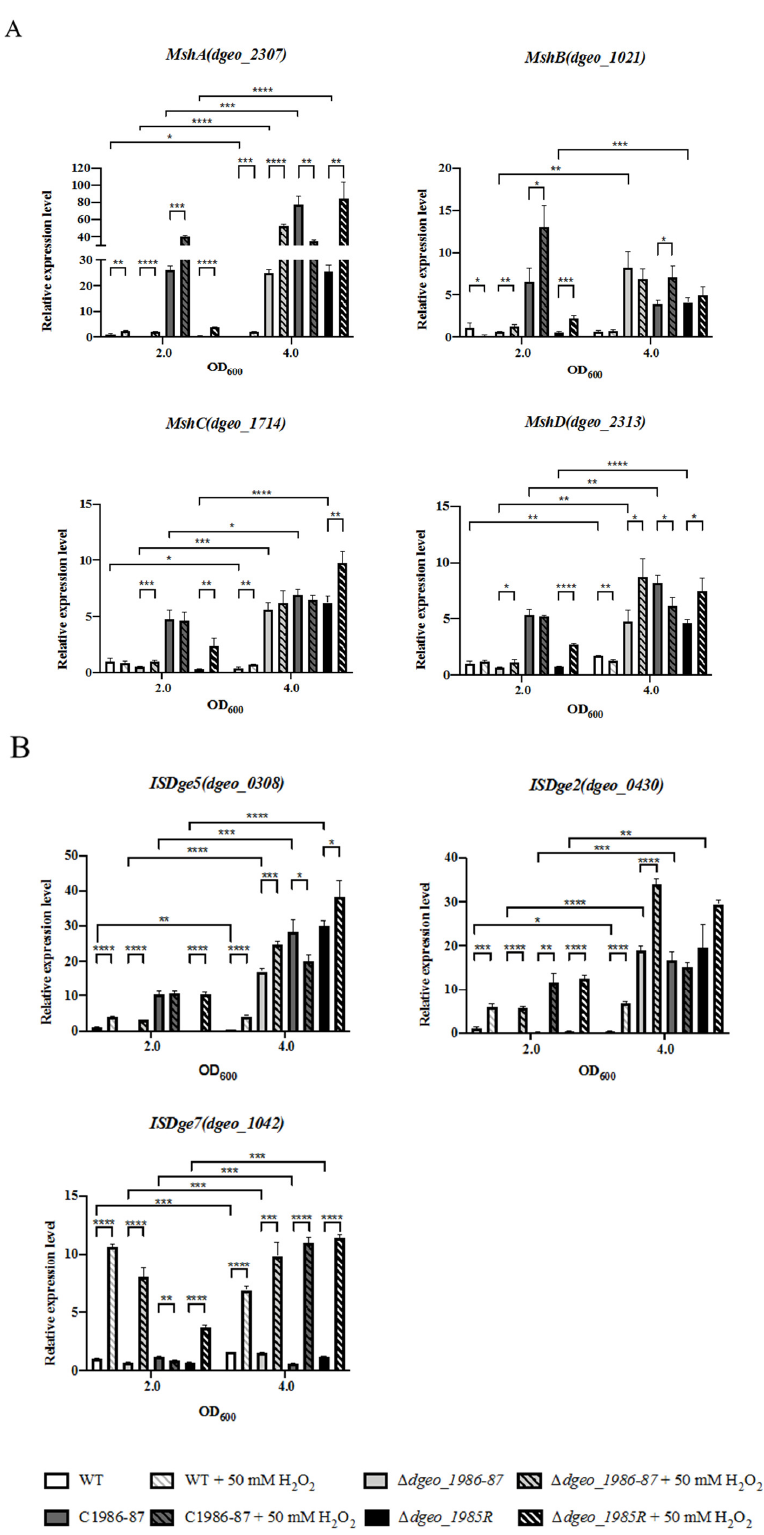
Figure 6. qRT-PCR analysis of four mycothiol biosynthesis genes ( A ) and three IS elements during active transposition ( B ) at two different growth phases in the presence and absence of hydrogen peroxide (50 mM). Pairwise comparisons were conducted using Student’s t -test to identify differences between the samples using the Prism TM software. p < 0.05 (*), p < 0.01 (**), p < 0.001 (***), and p < 0.0001 (****). Three actively transposed IS elements in redox-imbalanced conditions were also de- tected via qRT-PCR. The transposases (Tpase) of IS Dge2 and IS Dge5 were highly up-reg- ulated (over 10-fold increase) at the [L] growth phase both with and without hydrogen peroxide treatment except in the wild-type strain (Figure 6B). This IS Dge5 induction was consistent with the RNA-Seq data (Table 1). Interestingly, the Tpase of IS Dge7 was signif- icantly up-regulated (4 to 10-fold increase) in response to hydrogen peroxide treatment at both growth phases. However, in the absence of hydrogen peroxide, this Tpase was not fully induced at both growth phases. The induction levels of Tpase for IS Dge2 and IS Dge7 in RNA-Seq data were not substantially detected in the cystine importer-disrupted mu- tant (Table 1). Nevertheless, these two IS elements, as well as IS Dge5 , were actively trans- posed into the target genes ( dgeo _0523 and dgeo _0524) in both the cystine importer-dis- rupted and -overexpressed strains. Therefore, the active transposition of a particular IS element should be somehow affected by the growth phase and redox-imbalanced condi- tions. OxyR is highly induced in a growth phase-dependent manner, mainly via hydrogen peroxide treatment. A single catalase ( katE ) gene was also induced throughout the growth phase and was strongly induced by hydrogen peroxide treatment except in the comple- mented strains in both growth phases (Figure S4). The OxyR induction of the cystine im- porter-disrupted mutant and the complemented strain at the [E] stage did not correlate with catalase expression. Therefore, the general oxidative stress response regulator OxyR